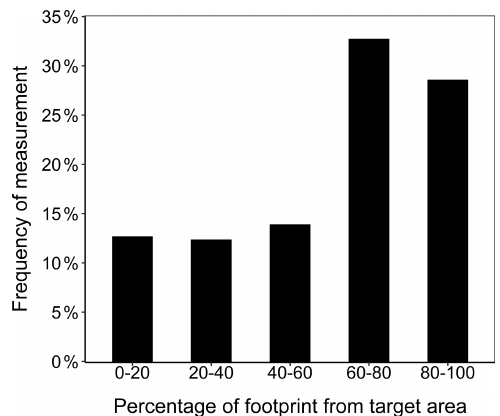
Figure 5. Distribution of the eddy-covariance measurements during the first post-fire hydrological year over five classes of the footprint area based on the degree of correspondence to the maritime pine